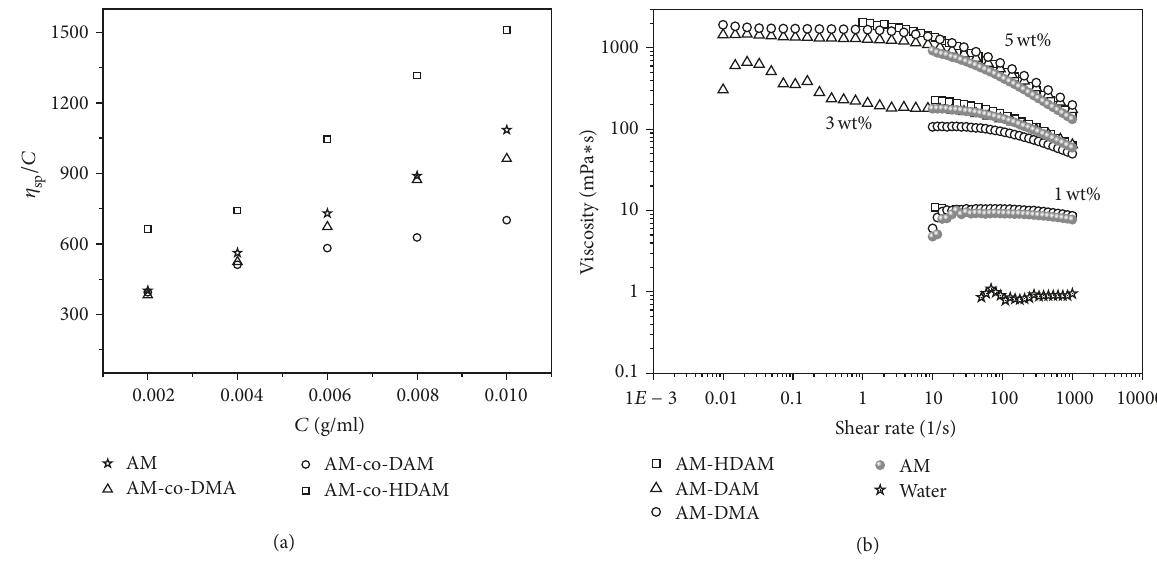
Figure 5: Influence of hydrophobic monomer length in (a) specific viscosity and (b) shear viscosity. Polymer concentration is indicated in the figure. Water viscosity is shown as